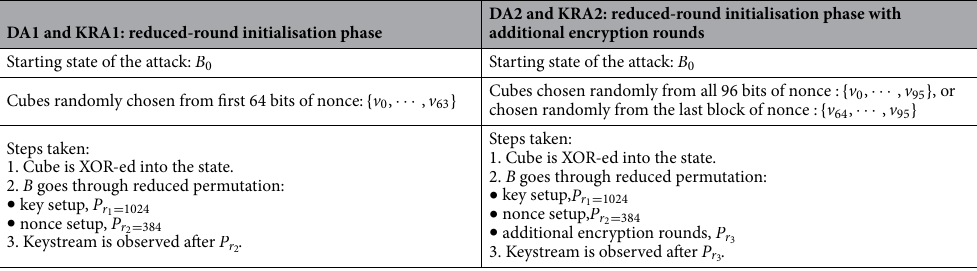
Table 2. Assumptions for DA1, DA2, KRA1,